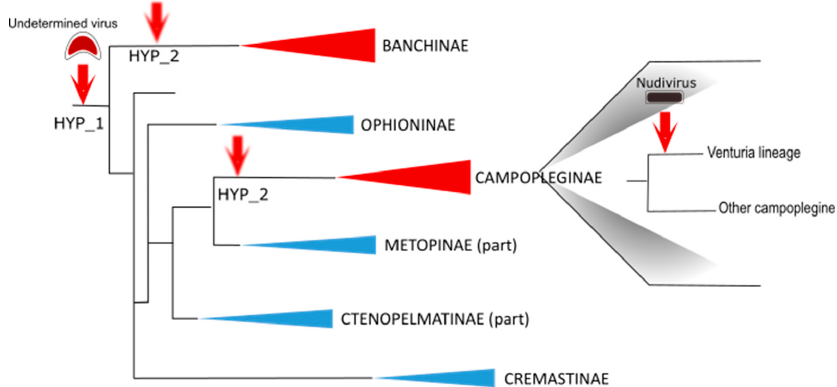
Figure 3. Schematic diagram illustrating virus acquisitions during ichneumonid evolution. A virus of undetermined nature was captured by an ichneumonid ancestor. It is not known whether the same event of integration (hypothesis HYP-1) or two distinct events with related viral progenitors (hypothesis HYP-2) led to the ichnoviruses presently associated with campoplegine and banchine. Remarkably, virus particles were described in the Campopleginae and Banchinae (indicated in red), but never in other ichneumonid subfamilies (indicated in blue). Subsequently, another event of virus integration occurred in the Venturia lineage of the campoplegine subfamily: an alphanudivirus was captured, giving rise to the virus-like particles described in the species Venturia canescens . Schematic phylogenic tree drawn based on Bennett et al., 2019 [1].